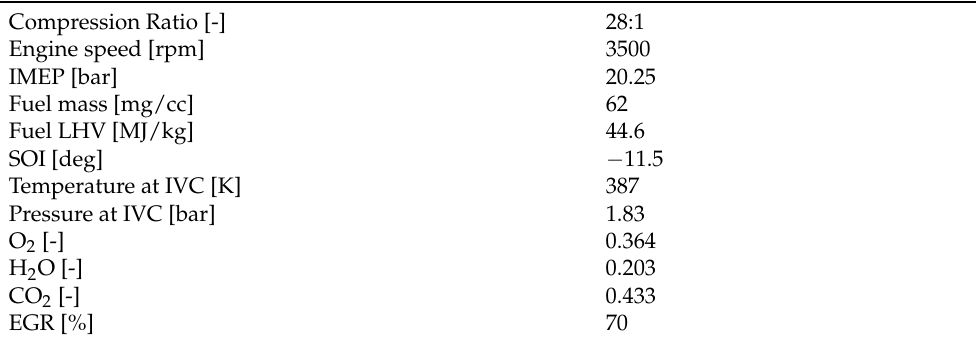
Table 5. Oxy-fuel combustion model boundary